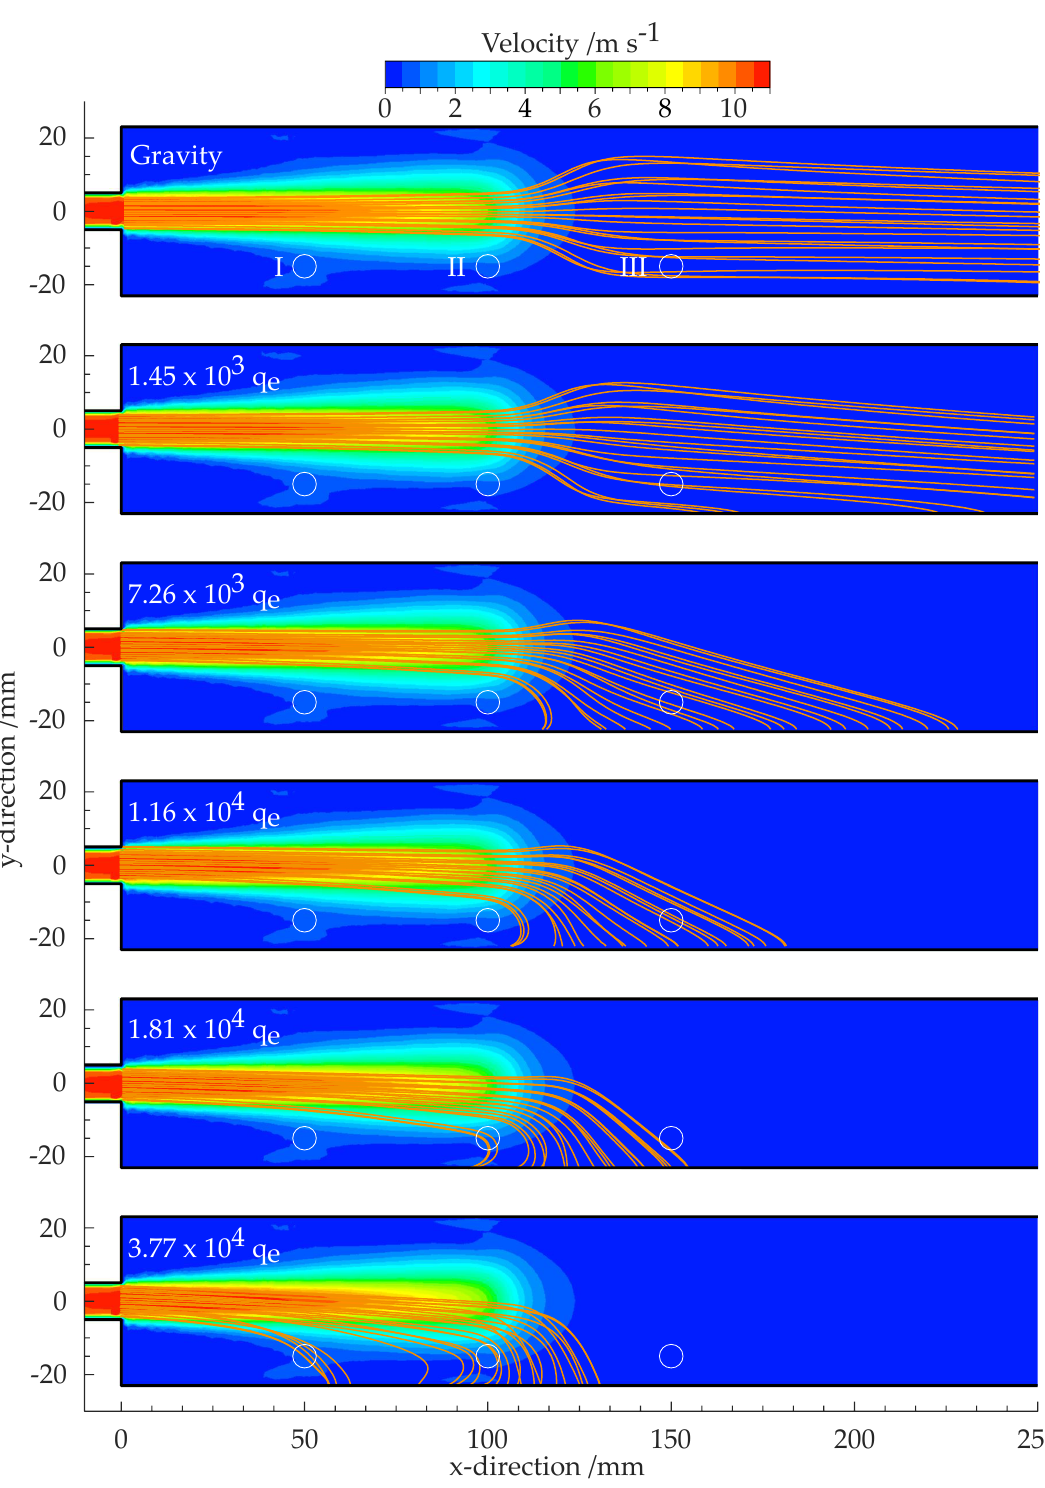
Figure 6. Trajectories of 16 µ m diameter spherical particles with di ff erent particle charges (multiples of the elementary charge calculated by Equation (1)). The measuring regions I, II, and III of the in situ particle size distribution are indicated by the white open circles. Depending on their net charges, certain particles are not detectable in every measuring region. The background visualizes the velocity profile. The jet formed at the outlet of the charging tube is clearly